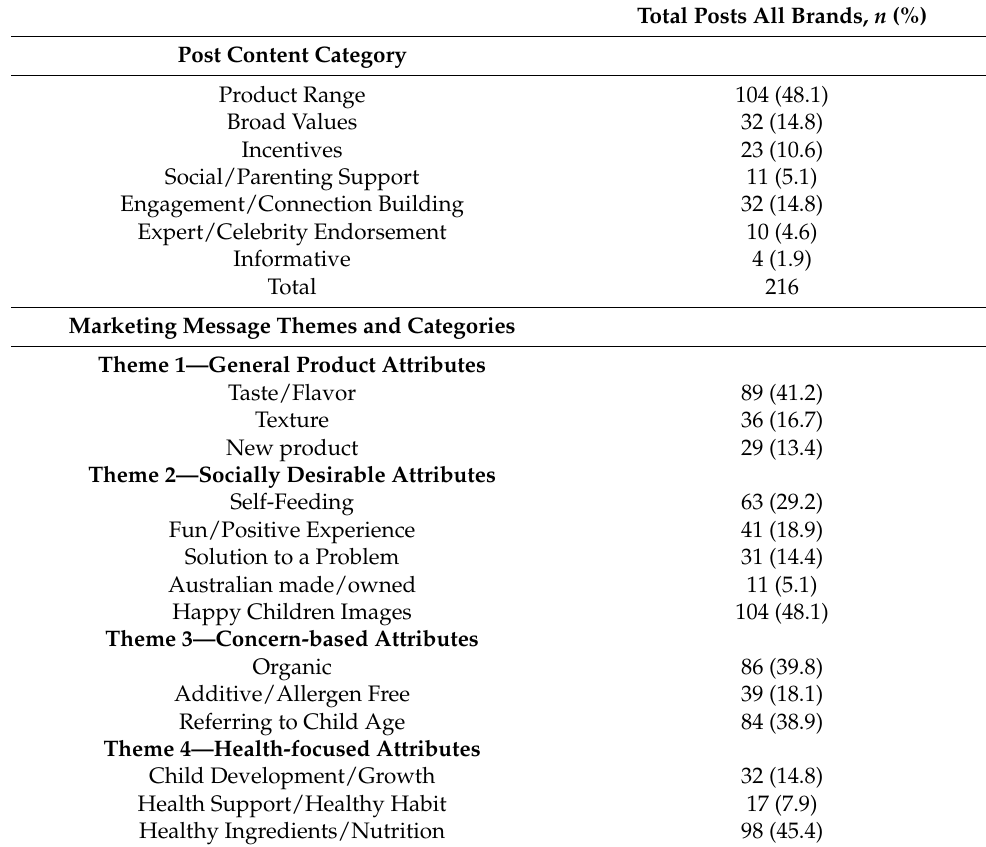
Table 4. Commercial complementary food brands’ Facebook post categories, marketing message themes and marketing message